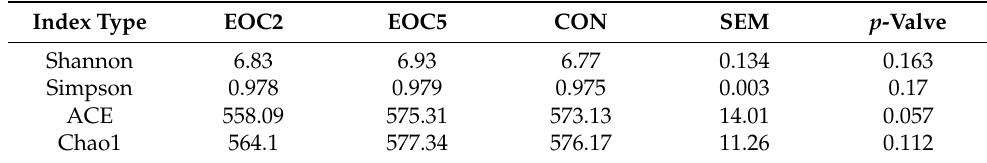
Figure 2. Diversity analysis. ( A ) operational taxonomic units-Venn (OTU-Venn) analysis; ( B ) dilution curve analysis; ( C ) nonmetric multidimensional scaling (NMDS) analysis; ( D ) Anosim analysis box plot.EOC, 0.1425% cobalt lactate + 1.13% oregano essential oil + 98.7275% carrier; CON, control group, that is, 0 mg · L − 1 EOC addition level. Table 4. Effects of different additive treatments on diversity